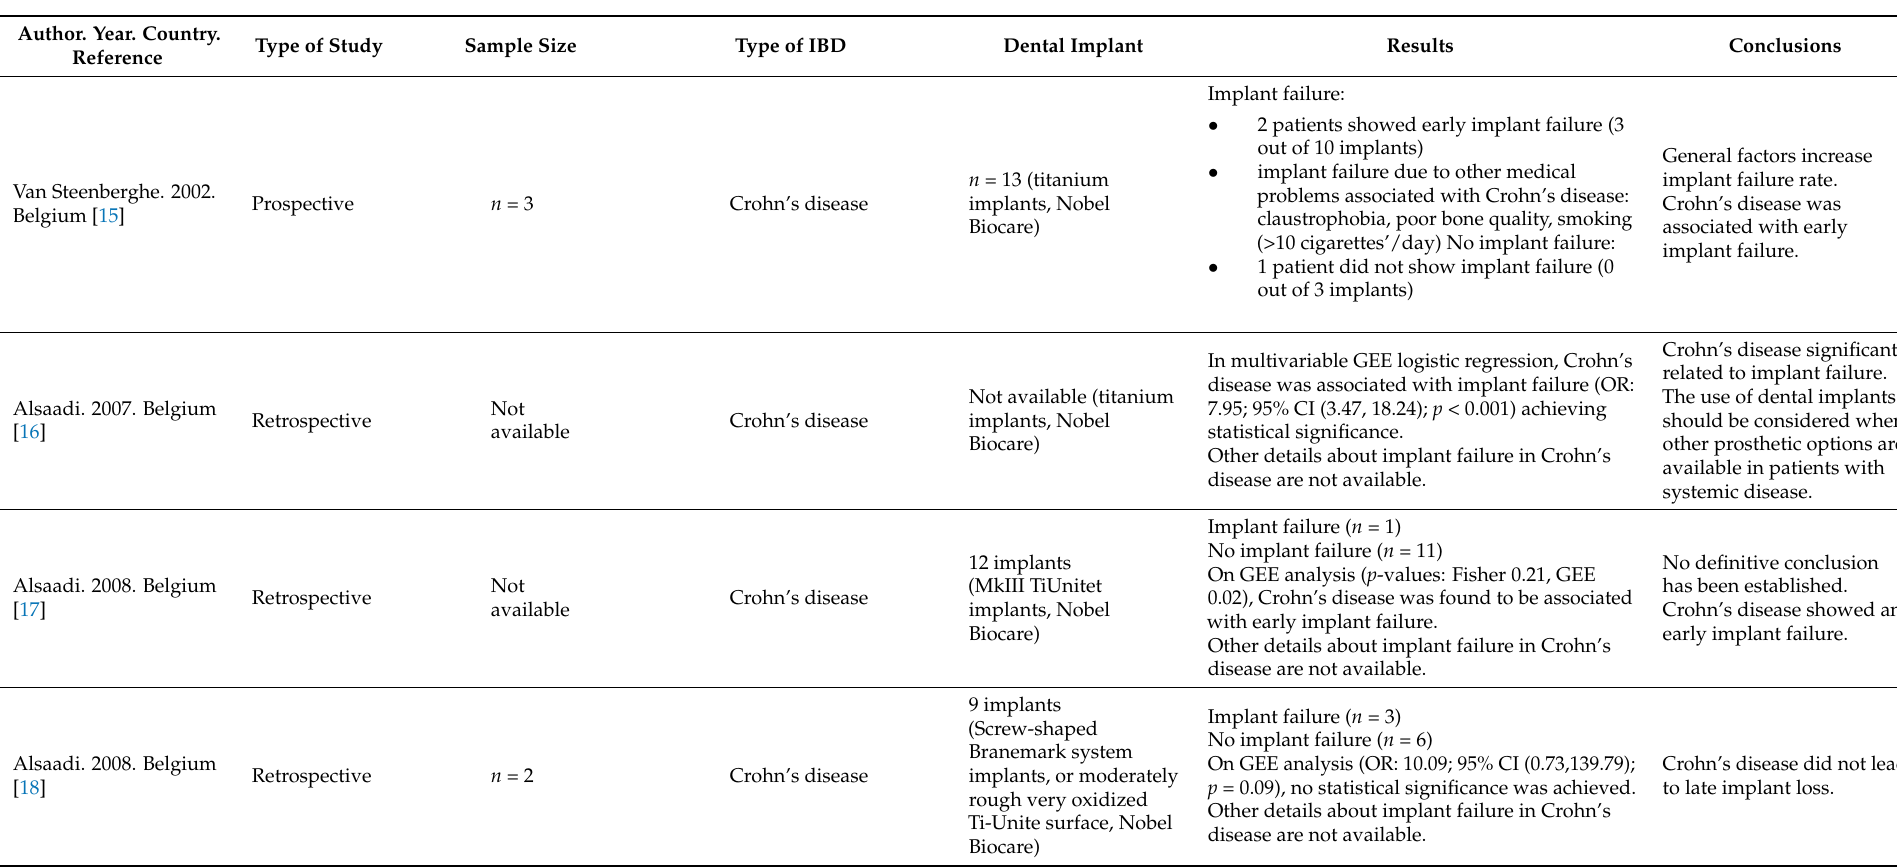
Table 1. Clinical studies